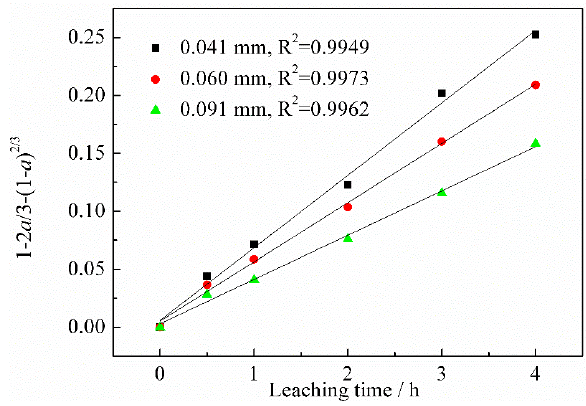
Figure 12. Effect of particle size on vanadium leaching efficiency.